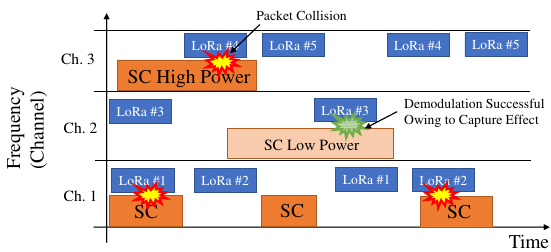
Figure 2. Accessing image of the multichannel environment under spectrum sharing between LoRa and the SC